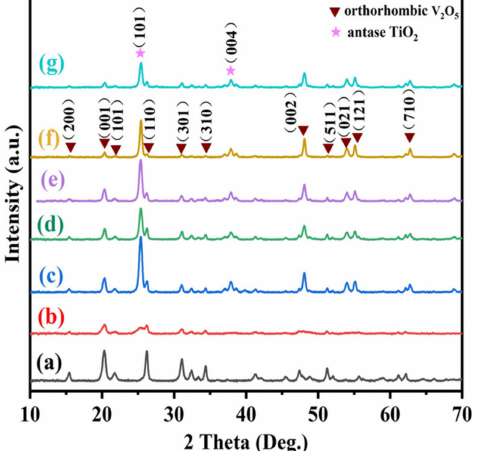
Figure 1. XRD patterns of ( a ) V 2 O 5 , ( b ) V 2 O 5 -TiO 2 , ( c ) 0.47Pt/V 2 O 5 -TiO 2 , ( d ) 0.39Pd/V 2 O 5 -TiO 2 , ( e ) 0.46PdPt 2.10 /V 2 O 5 -TiO 2 , ( f ) 0.41PdPt 0.85 /V 2 O 5 -TiO 2 , and ( g ) 0.49PdPt 0.44 /V 2 O 5 -TiO 2